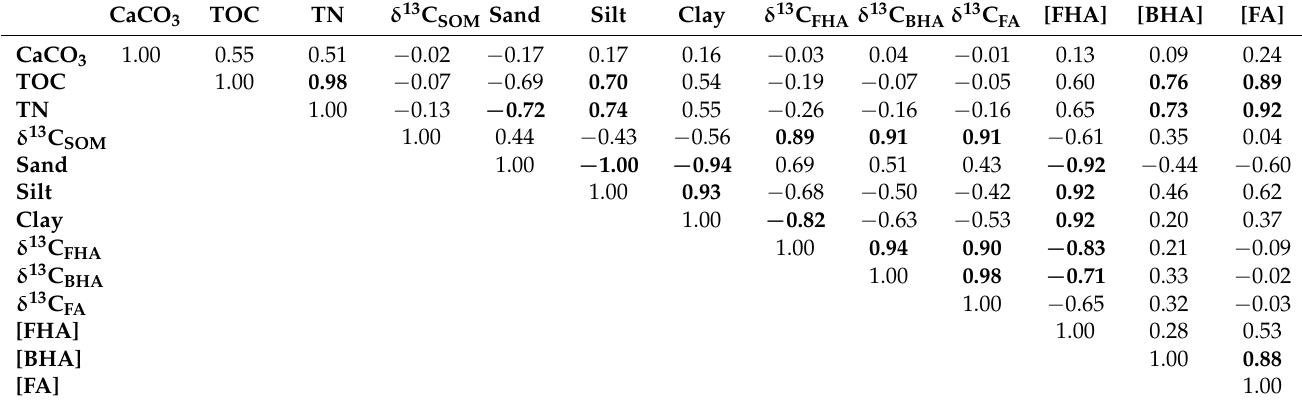
Table 1. Pearson’s correlation matrix between paired parameters in bulk sediments (N = 13; p < 0.05). Correlation coefficients > 0.69 are indicated in bold.